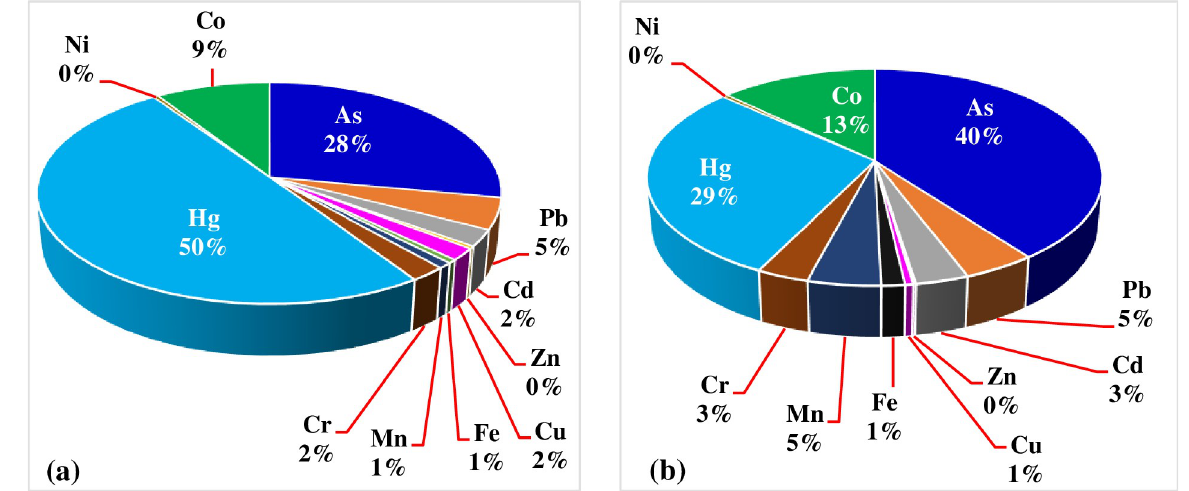
these vegetables from the area as the values were exceeded the maximum threshold value of 1 x 10 − 4 [11,45,48,50,52,53,73,77–79]. The corresponding TCR of Pb were 9.70 x 10–6 and 2.02 x 10–5, respectively due to the consumption tomato and cabbage. The TCR values for Pb were observed to be less the maximum threshold value and hence indicating no cancer risk from Pb to the adult population in the area through consumption of both tomato and cabbage. In com- pression with the literature reports, the TCR value for As (1.9 x 10 − 8 ) reported by Shaheen et al. [55] was found to be much less that the value (9.10 x 10 − 4 ) we have reported in this study. Similarly, Antoine and co-workers [52] have reported a TCR value of 7.61 x 10 − 6 for As due to the consumption of tomato, which is much less the data we have reported in this study.